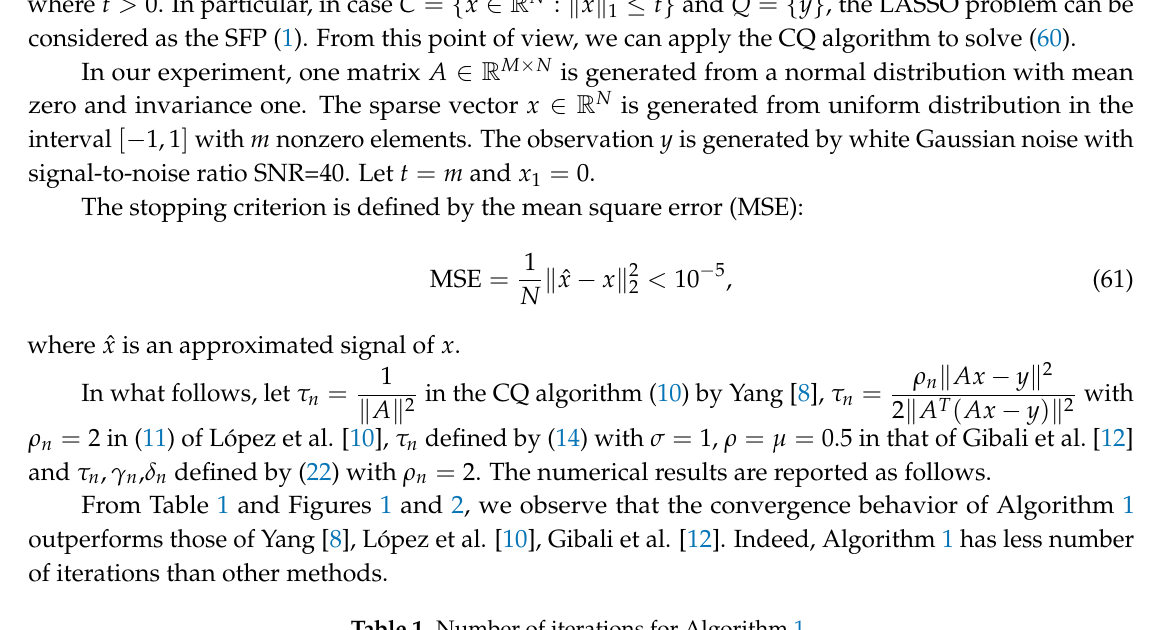
Table 1. Number of iterations for Algorithm